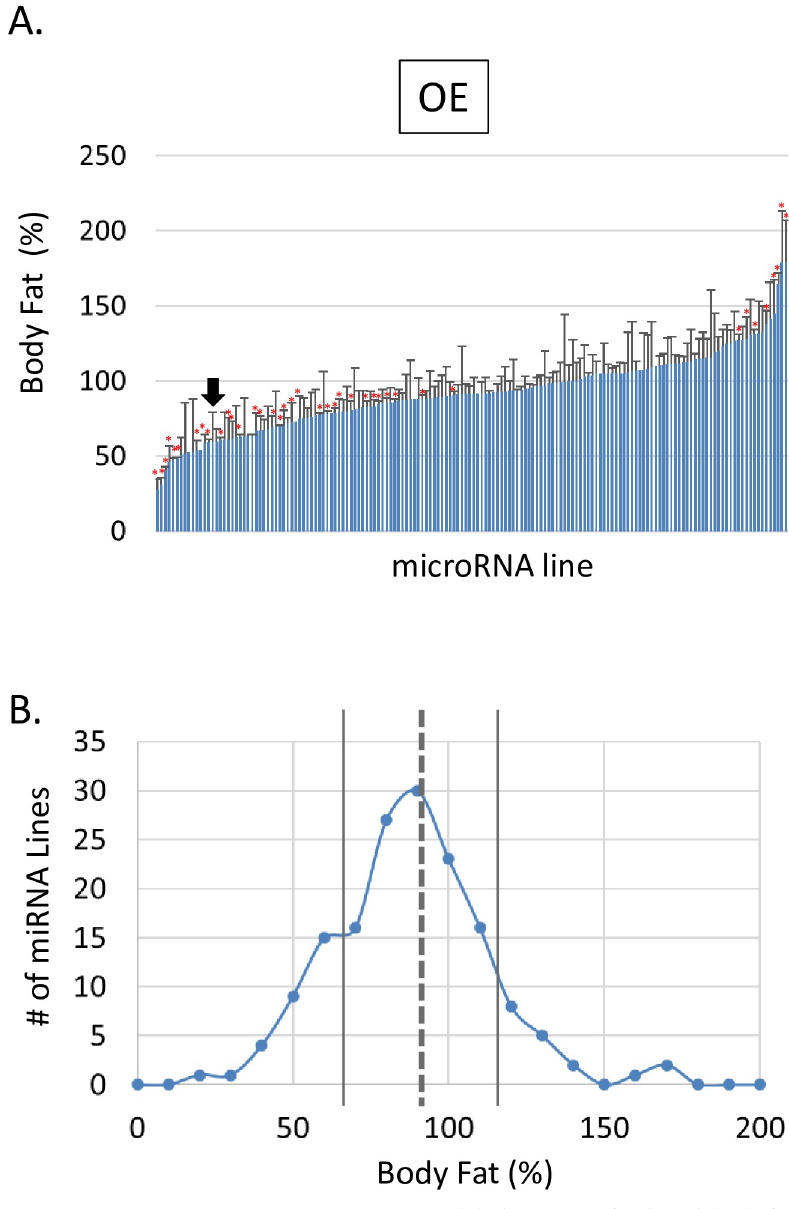
Fig 2. Gain-of-function miRNA lines altered body fat. (A) The amounts of triglyceride (TG) of F1 males from the cross of Act5C-Gal4 and UAS-miRNA were determined using the colorimetric method. Then, the TG content of each miRNA line was compared to that of the W 1118 control male; the relative amount of body fat (%) was calculated using the following formula. Relative Body Fat (%) = (TG miRNA /TG control ) X 100; � , P < 0.01 by Student’s t-test. Each bar graph represents a different miRNA line; error bars represent the standard deviation. The black arrow shows miR-969. (B) Each miRNA line was assigned to a bin depending on their male body fat contents. The bins were between 0% and 200% fat contents with 10% increments. The dotted line represents the mean (91.7%); two solid lines (66.5% and 116.9%) denote one standard deviation from the